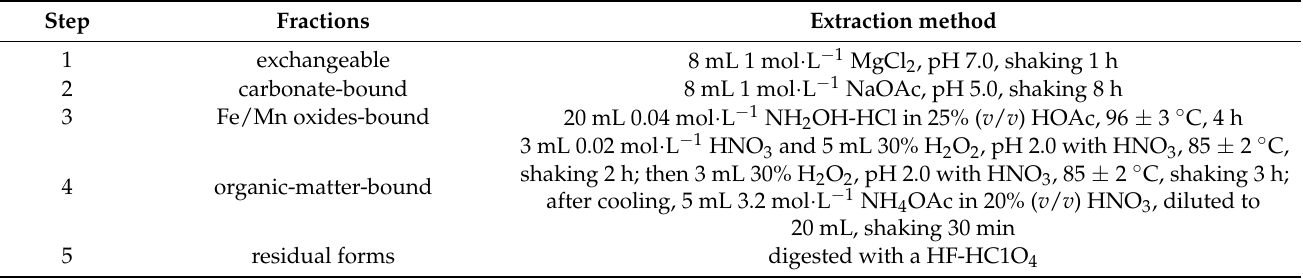
Table 1. Procedure for the five-step sequential extraction of Cd from